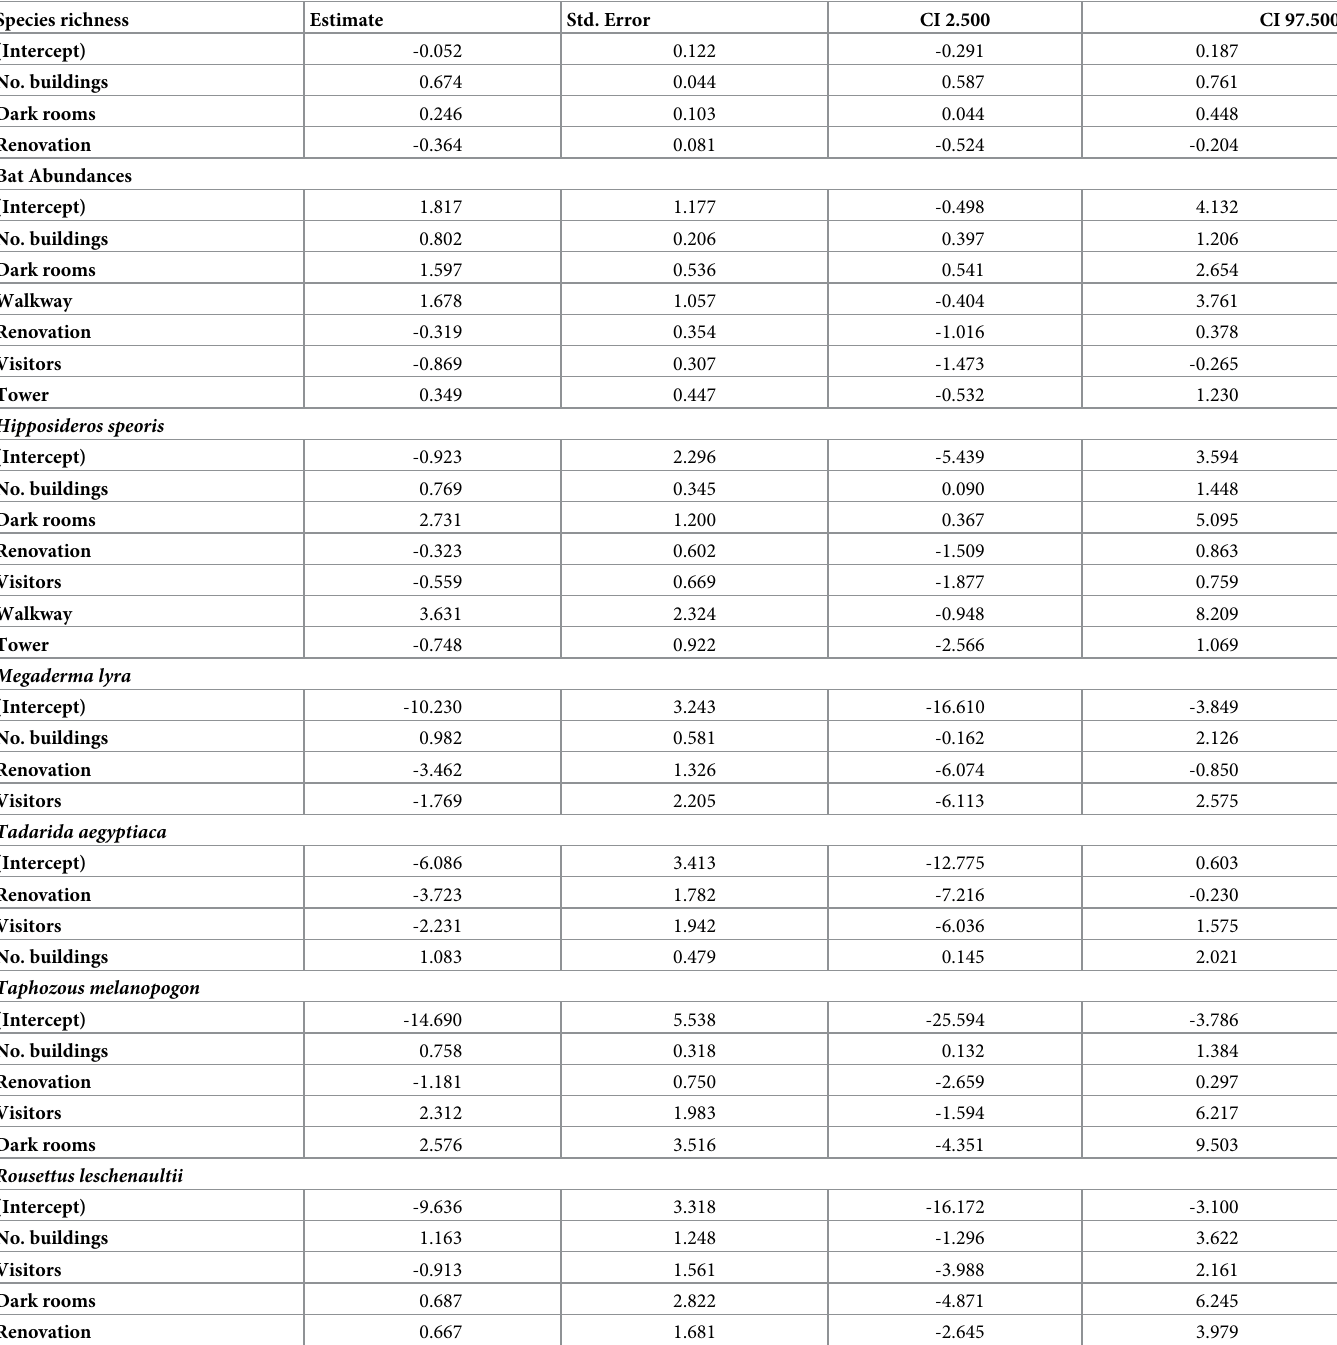
Table 2. Effects of temple characteristics on species richness (lmer model) and bat abundances (glmmadmb model). Temple id and year are included as random fac- tors. The top models’ average estimates and confidence intervals are given, and the individual model details are included as (S1